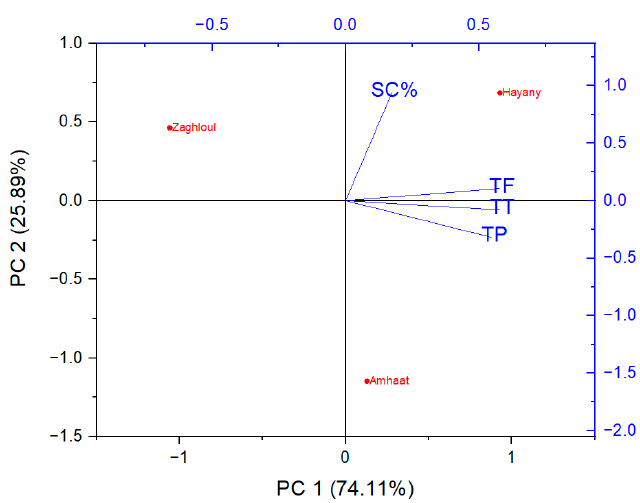
Figure 3. Principal component analysis (PCA) projections on PC1 and PC2. Plotted points are mean values of each studied parameter of extracts from the fresh fruits of “Zaghloul”, “Hayany”, and “Amhaat” Egyptian dates. TF: total flavonoids, TP: total phenolics, TT: total tannins, SC%: DPPH scavenging activity (%).